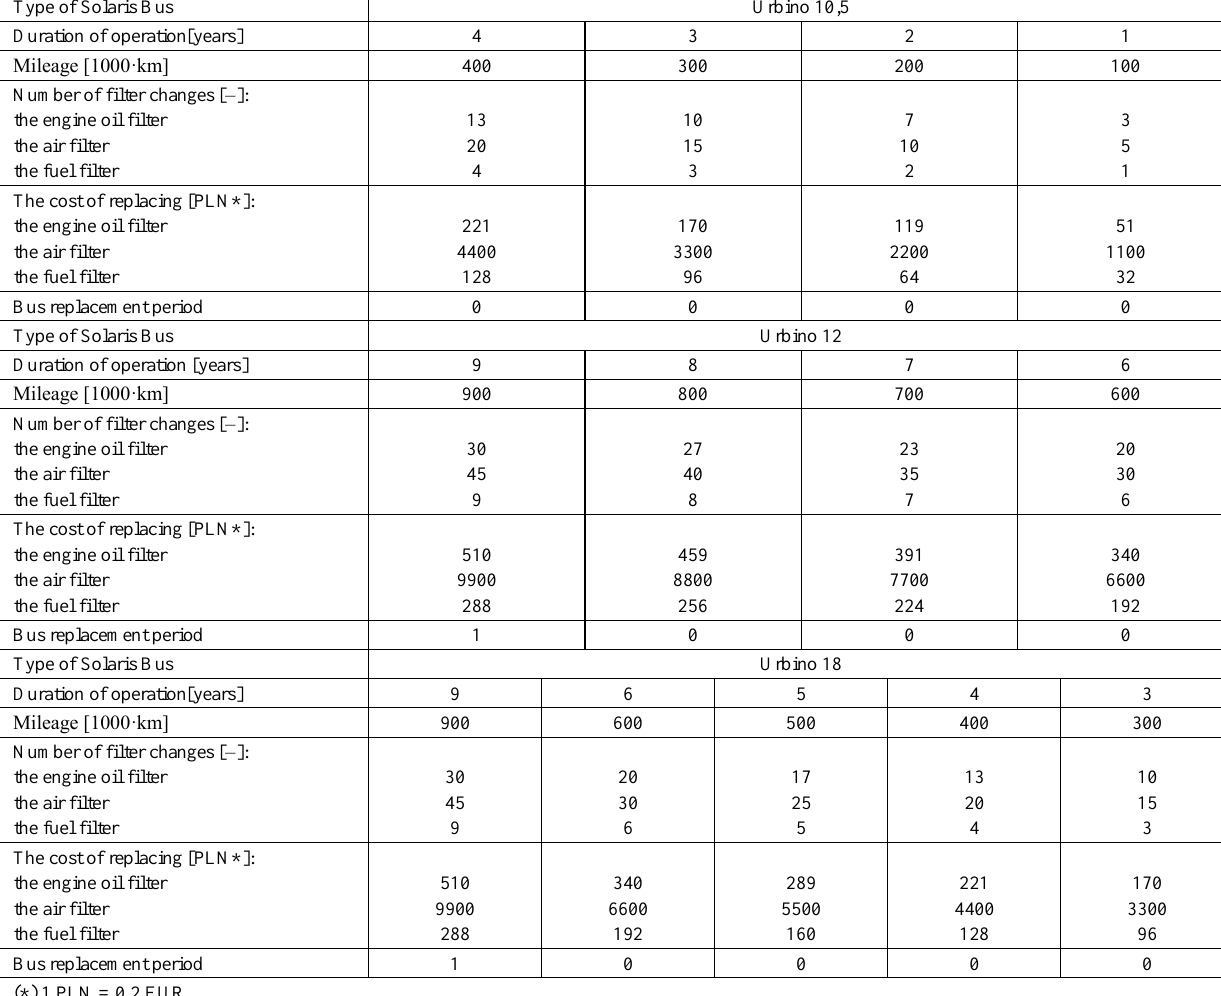
Table 4. Values of the analyzed parameters of selected types of